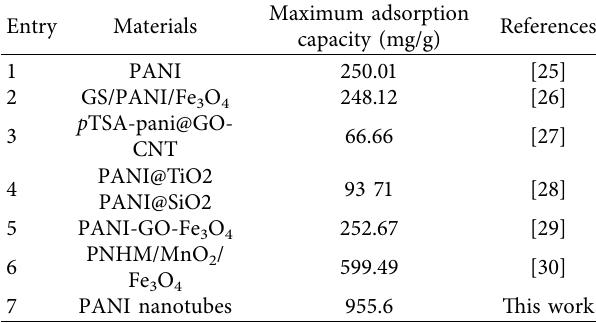
Table 4: Comparison of the adsorption capacity of different ad- sorbents for Congo red.